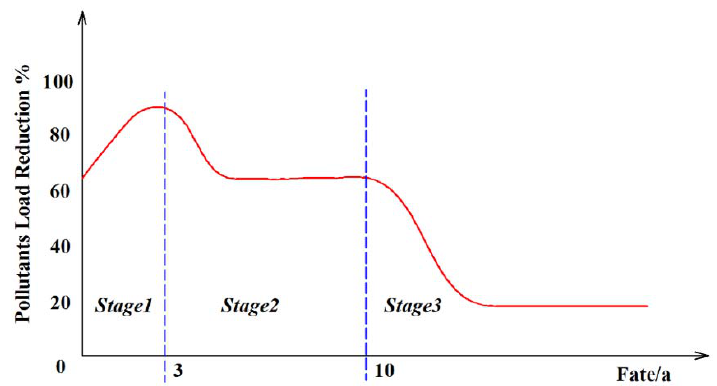
Figure 9. Thepollutant load reduction–rain garden running fate curve. Note: Stage 1 refers to the period of pollutant purification growth; Stage 2 refers to the period of pollutant purification stability; Stage3 refers to the period of pollutant purification attenuation.